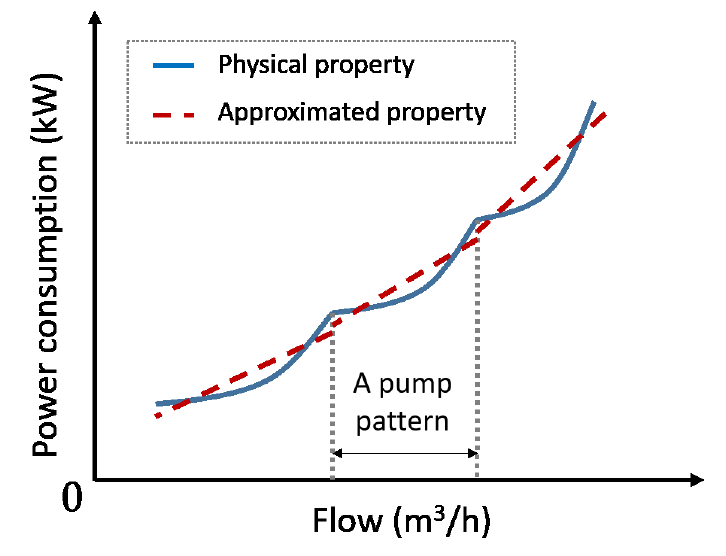
Figure 3. Approximated properties of the water